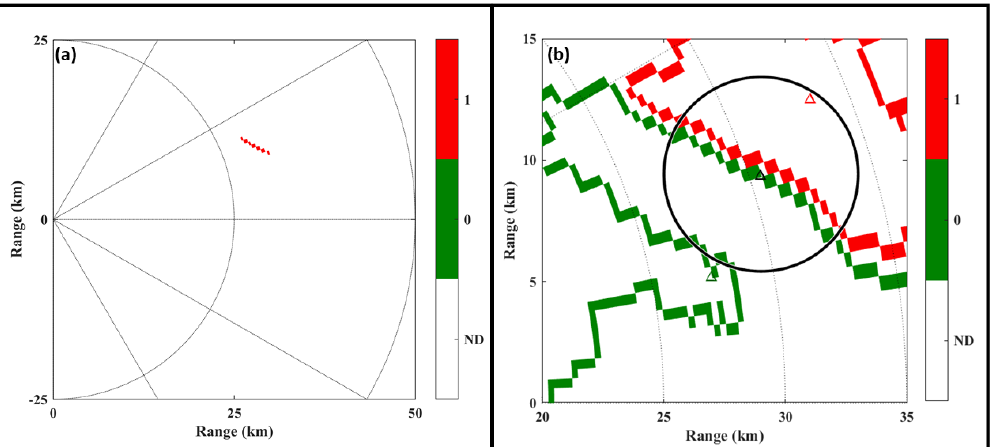
Figure 13 Figure 13. Extraction of zero Doppler velocity line and identification of downburst center. ( a ) Extraction result of zero Doppler velocity line and ( b ) recognition result of downburst cen- ter. In Figure 13b, the red outline represents the positive velocity area, and green outline represents the negative velocity area; the red triangle represents the maximum value of the positive velocity area, and green triangle represents the minimum value of the negative velocity; the black triangle represents the center of the downburst, and black circle indicates the range of the downburst, while the radius of the circle is 4